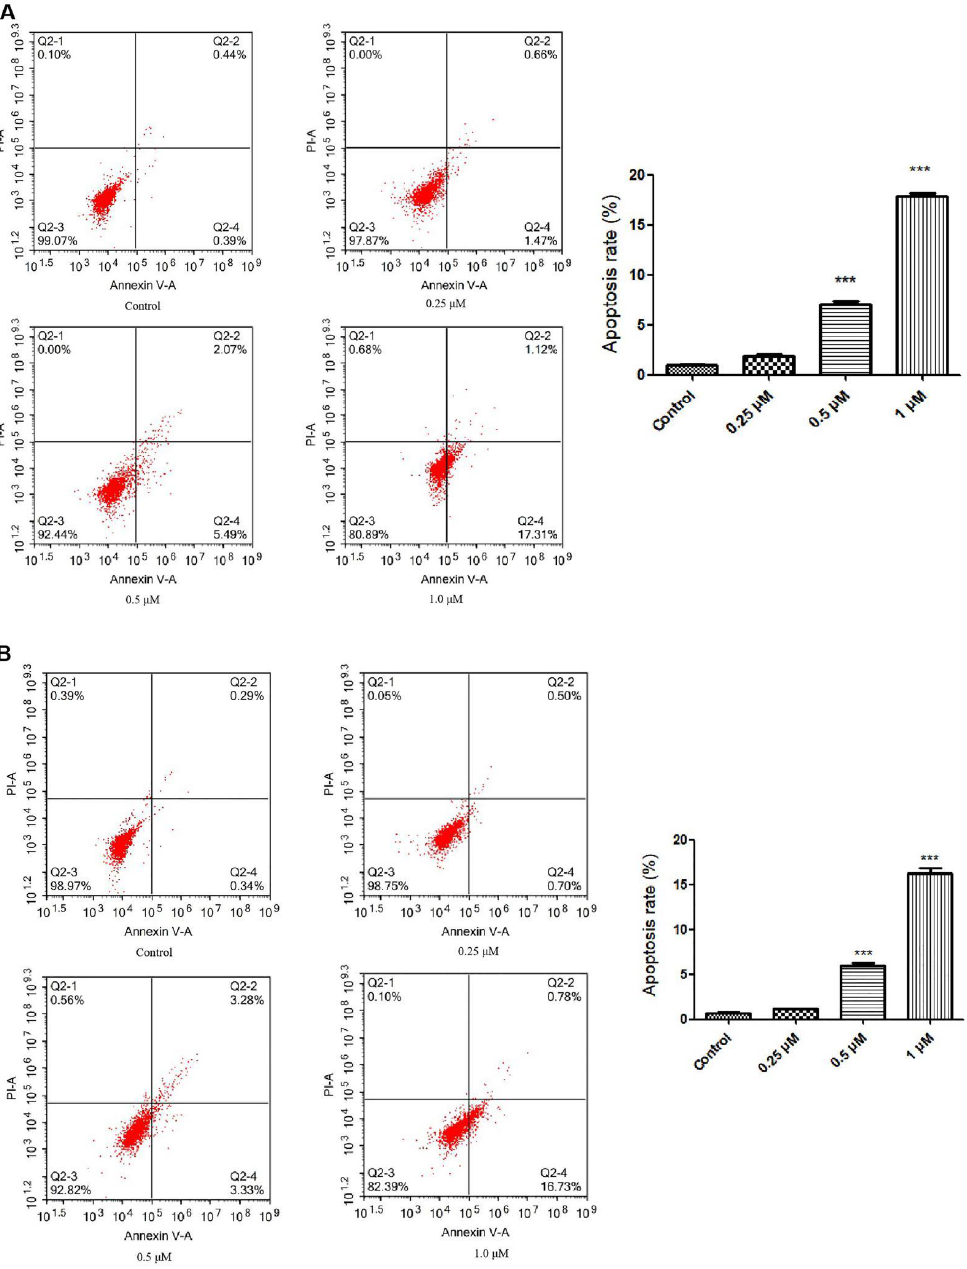
Figure 3. Compound 2j induced apoptosis in Jurkat Clone E6-1 and THP-1 cell lines. ( A ) Compound 2j induced apoptosis in Jurkat Clone E6-1 cell line. Jurkat Clone E6-1 cells were treated with 0.25,